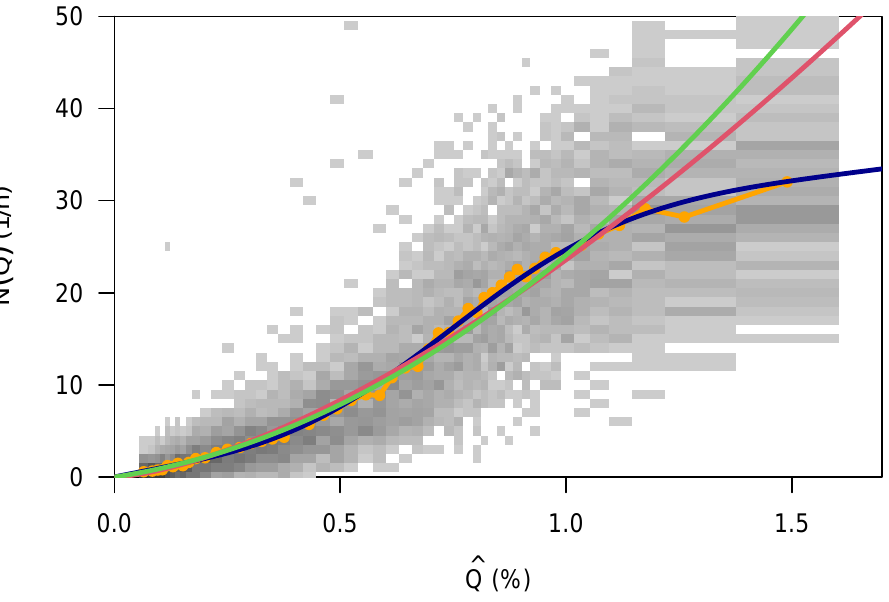
Figure 10. N versus ˆ Q data, together with a line that connects the means computed from the data, and three different models: a gam (dark blue), a second-order polynomial model (green), and a power-law model Q β 1 (red).